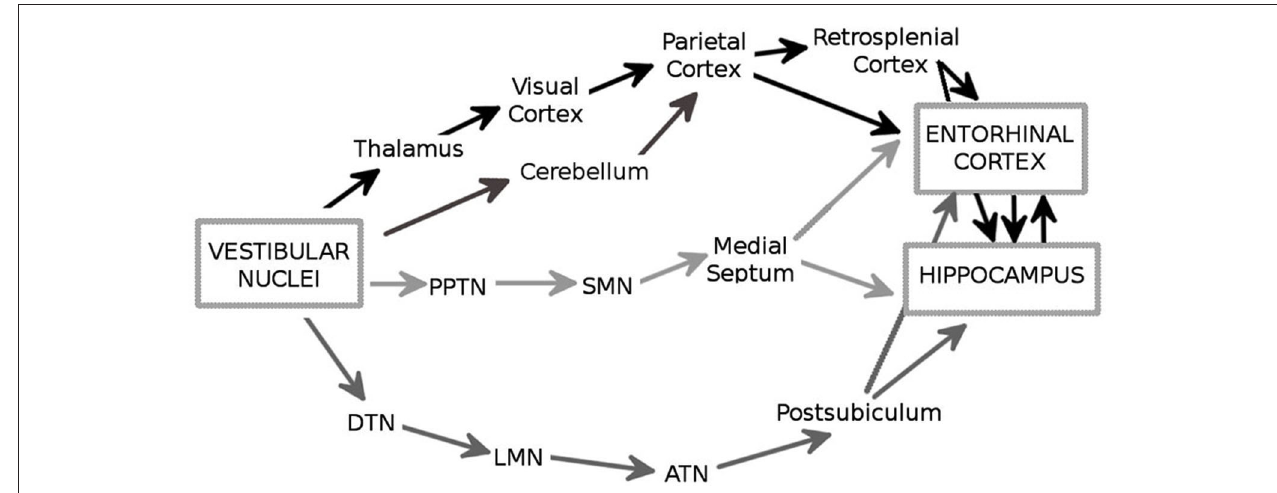
FIGURE 1 | The major anatomical pathways (in black, dark gray and light gray) through which the vestibular signals reach the hippocampus and the entorhinal cortex (EC)